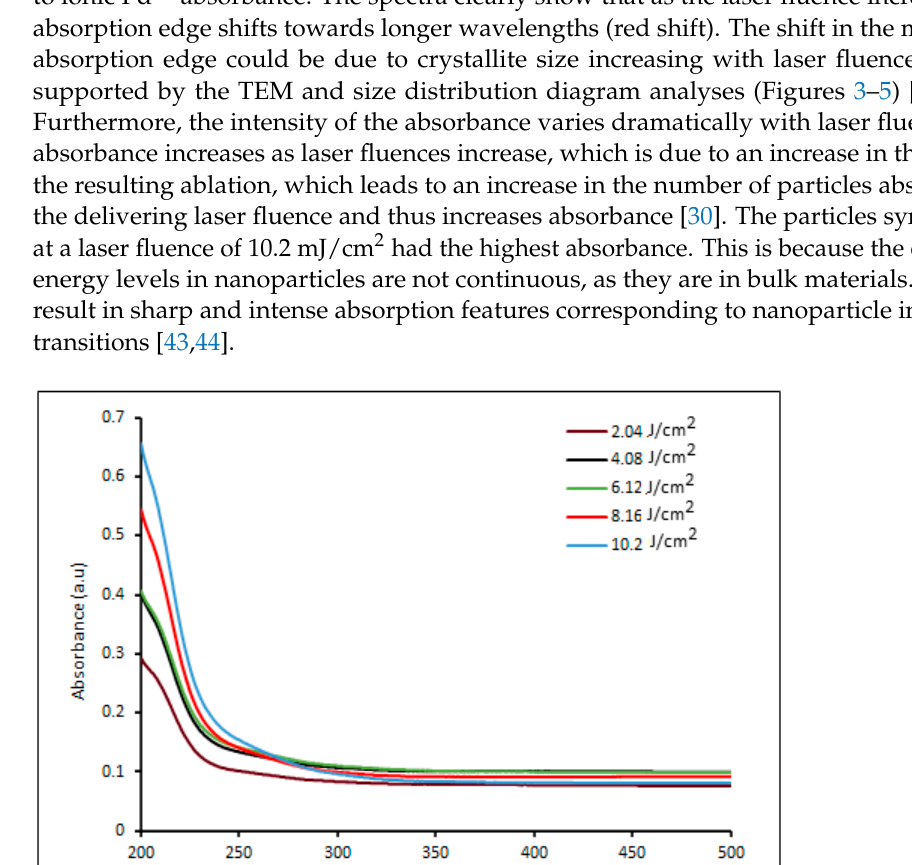
Figure 5. ( a ) TEM image of palladium nanoparticles (Pd NPs) prepared by pulsed laser ablation of palladium target in distilled water at 10.2 J/cm 2 , ( b ) size distribution.